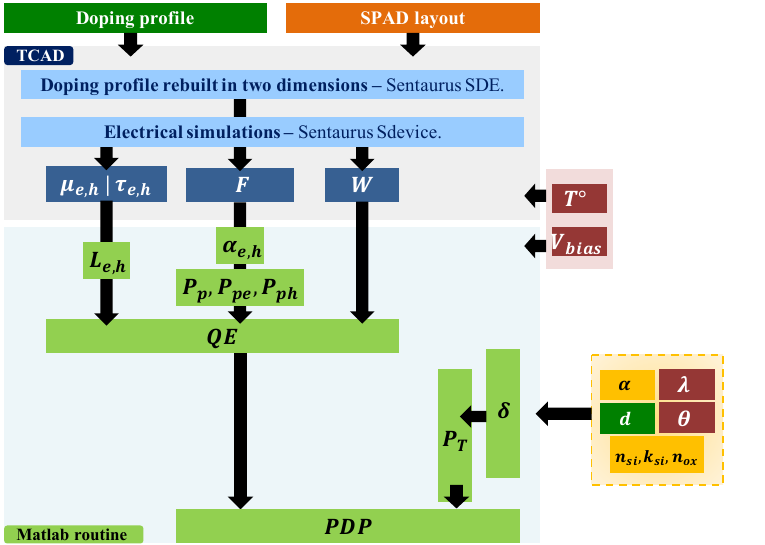
Figure 3. Photon Detection Probability (PDP) modeling implementation, based on TCAD, Matlab routine, measurements and external